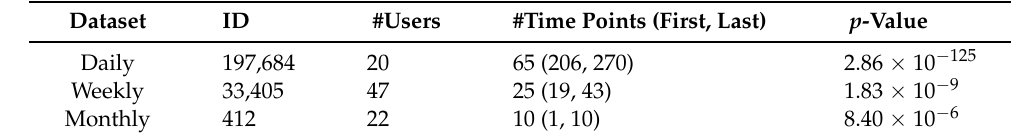
Table 5. Constant biclusters tolerating noise picked for each of the temporal granularities.